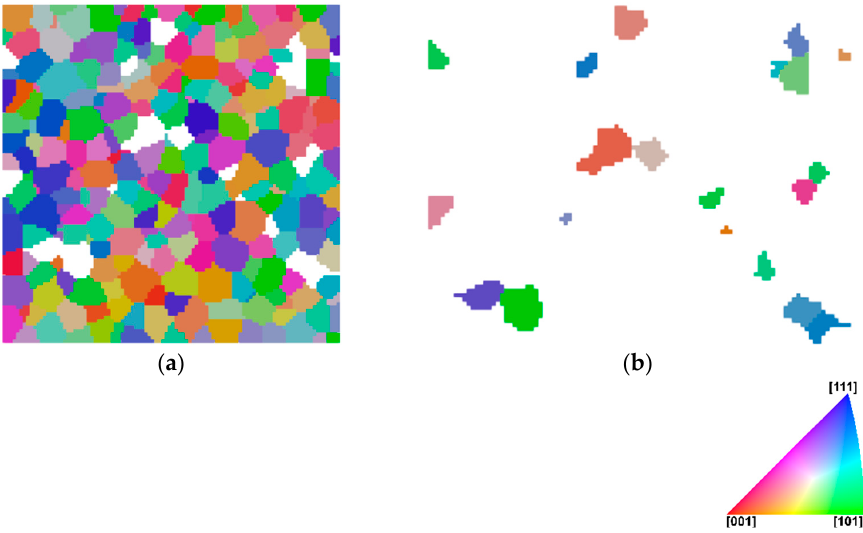
Figure 8. Generated RVE for TRIP steel simulations: ( a ) steel matrix; ( b ) MgO-PSZ particles.